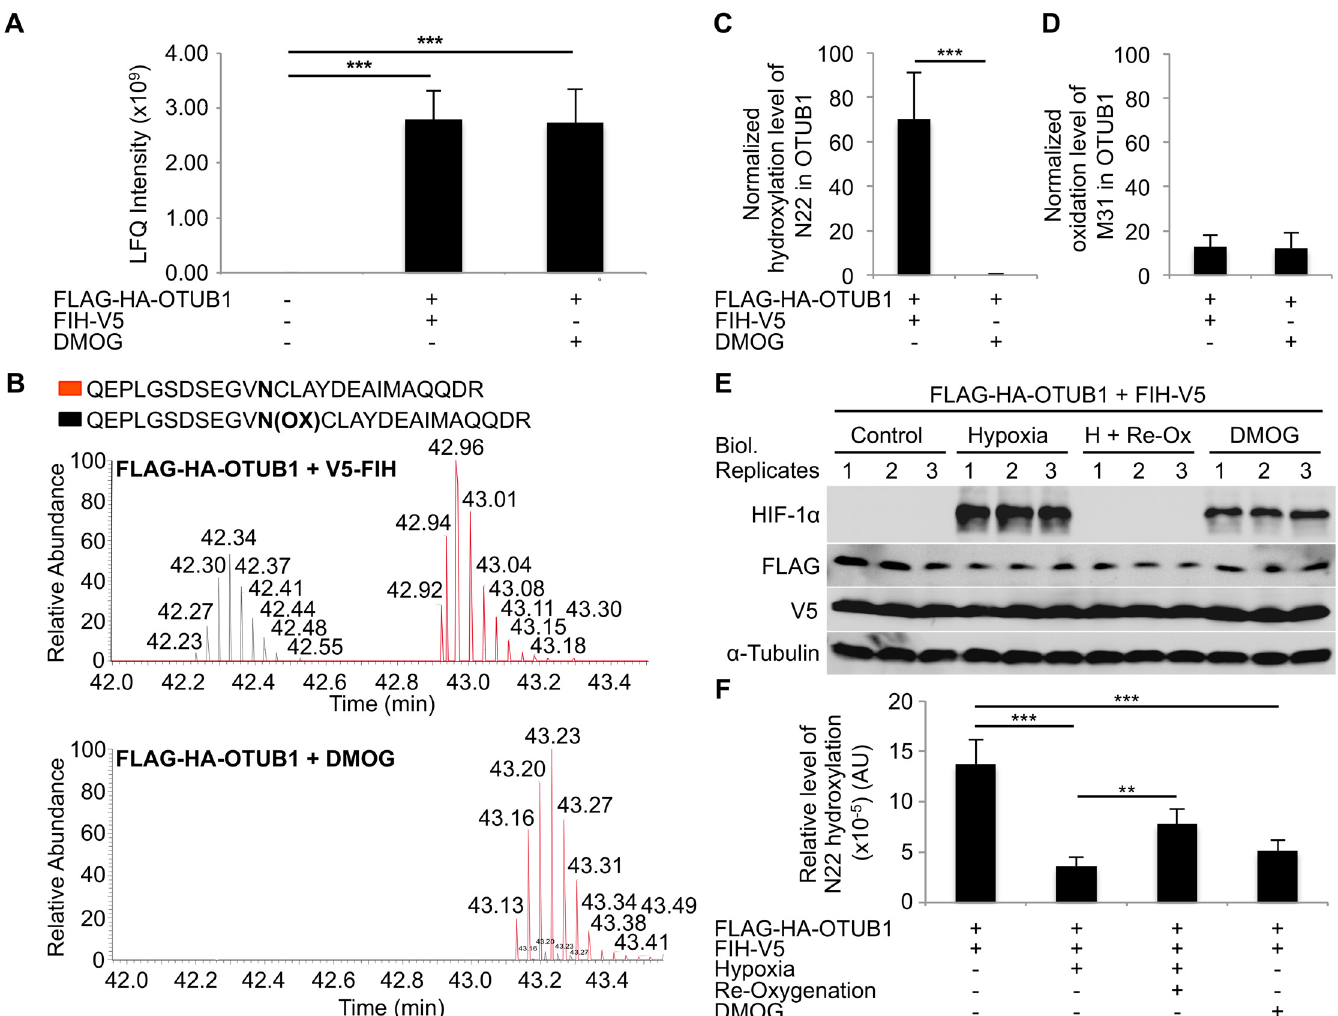
Fig 2. OTUB1 is enzymatically hydroxylated on asparagine 22. HEK293 cells were transfected with either an empty vector (negative control conditions), pFLAG-HA-OTUB1 and pFIH-V5 with 50 μ M ascorbate (high asparagine hydroxylation capacity conditions), or pFLAG-HA-OTUB1 and an empty vector with 2 mM DMOG (low hydroxylation capacity conditions). Following FLAG-specific immunoprecipitation samples were analyzed by mass spectrometry. (A) Mass spectrometric analysis of the relative amount of immunoprecipitated OTUB1 in each sample. (B) Extracted ion chromatogram demonstrating levels of OTUB1 peptides containing hydroxylated and non-hydroxylated asparagine 22 in cells exposed to either high or low hydroxylation capacity conditions. (C) Hydroxylation levels of asparagine 22 of OTUB1 in high and low hydroxylation capacity conditions. The detected hydroxylation peptide intensity of each sample was normalized to the amount of non-hydroxylated OTUB1 N22 peptide intensity detected. (D) Oxidation levels of methionine 31 in OTUB1 in high and low hydroxylation capacity conditions. The detected oxidation peptide intensity of each sample was normalized to the amount of non-oxidized OTUB1 M31 peptide intensity detected. (E) HEK293 cells were transfected with pFLAG-HA-OTUB1 and pFIH-V5 for 24 h prior to an 8 h treatment with 50 μ M ascorbate (all samples) in combination with either 1 mM DMOG or incubation in normoxia (control; 21% O 2 ) or hypoxia (0.2% O 2 ). For instantaneous re- oxygenation, hypoxic media was exchanged with normoxic media and samples were incubated for 1 h in normoxia following the 8 h of hypoxic exposure (H + Re-Ox). Treatment and overexpression efficiency were determined by western blot. (F) Hydroxylation levels of OTUB1 N22 of the samples shown in (E) after FLAG-specific immunoprecipitation. The detected hydroxylation peptide intensity of each sample was normalized to the overall amount of total OTUB1 intensity detected. The experiments were performed with three biological replicates and two technical replicates (in the case of mass spectrometric analysis) per sample. Data are represented as mean + standard deviation (SD). ** p < 0.01, *** p < 0.001 by Student ’ s t test for (A) and (C) and by one-way ANOVA followed by Tukey post test for (F). AU: arbitrary units. The underlying data of panels A, C, D, and F can be found in S1 Data.